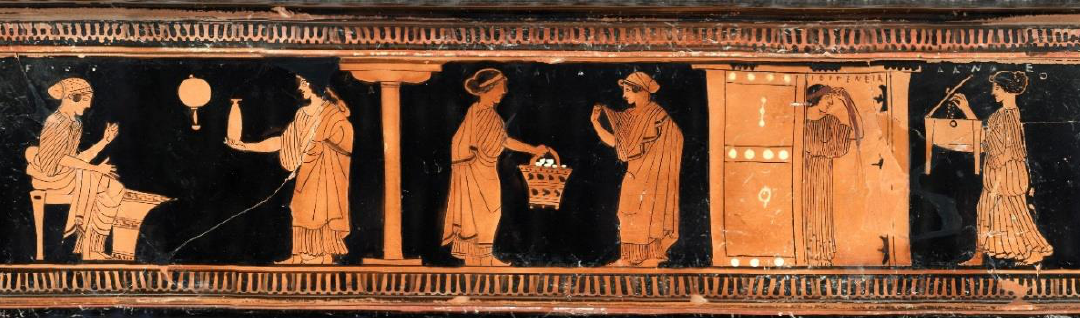
Figure 15. Athenian red-figure pyxis with women within the home, attributed to a follower of Douris. 475 – 425 BCE. Vase from Attica. London, British Museum 1873,0111.7, BAPD 209970. Credit: Image provided by the British Museum © Trustees of the British Museum.